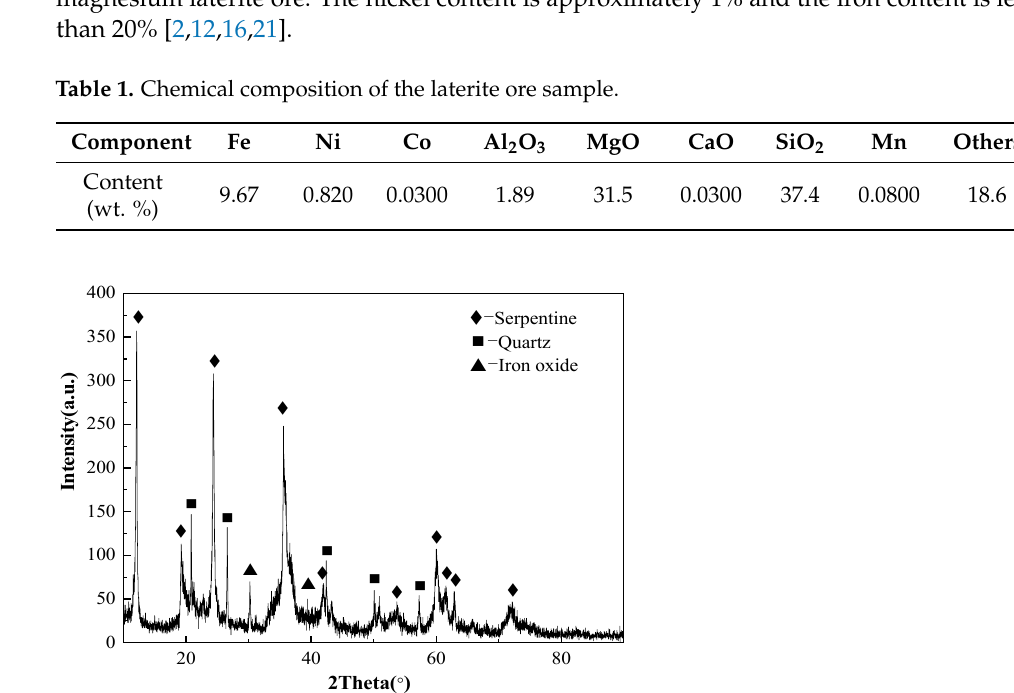
Figure 1. The flow chart of reduction roasting-magnetic separation experiment of laterite nickel ore.